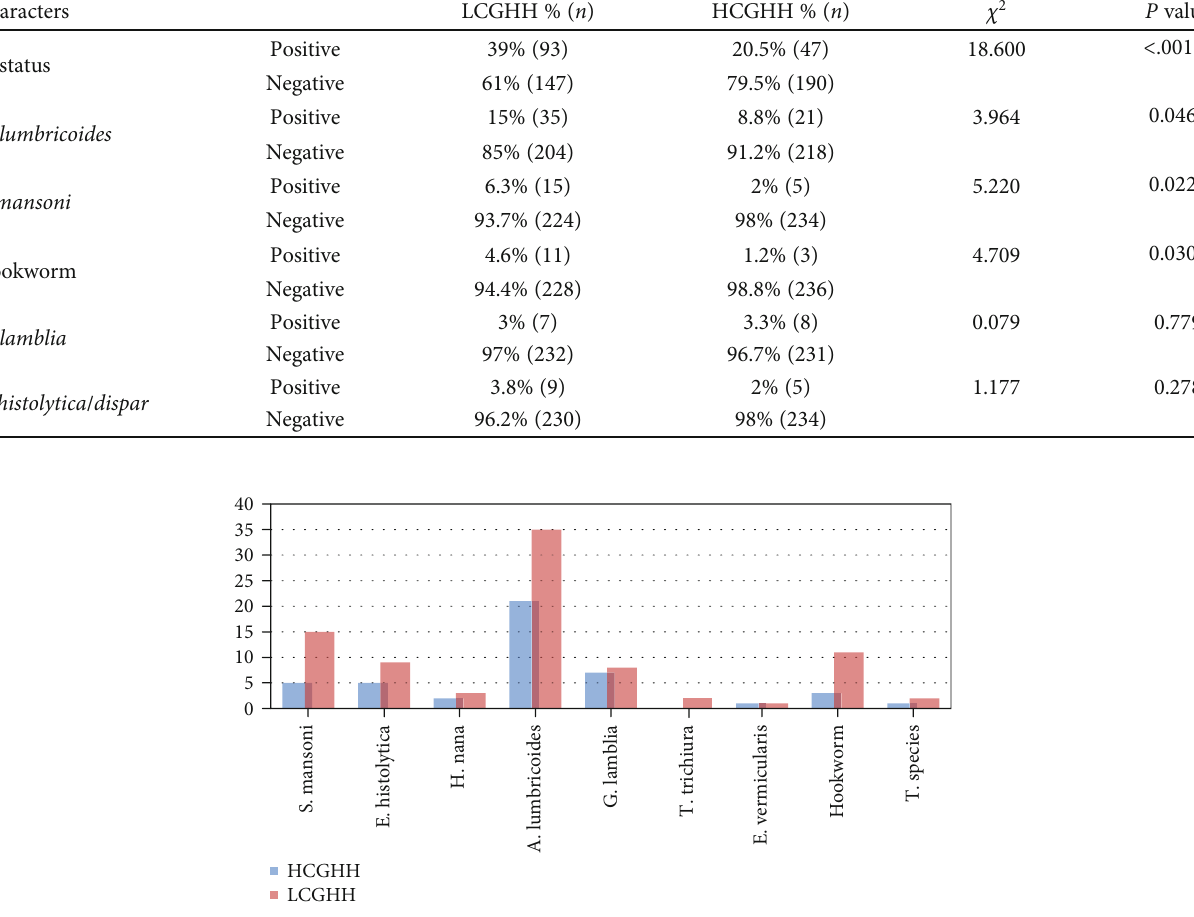
Figure 1: Frequency distribution of intestinal parasites. Table 3: Intensity of helminth infection in low and high coverage of graduated households ’ districts with intestinal parasite infections Northwest Ethiopia, 2019.